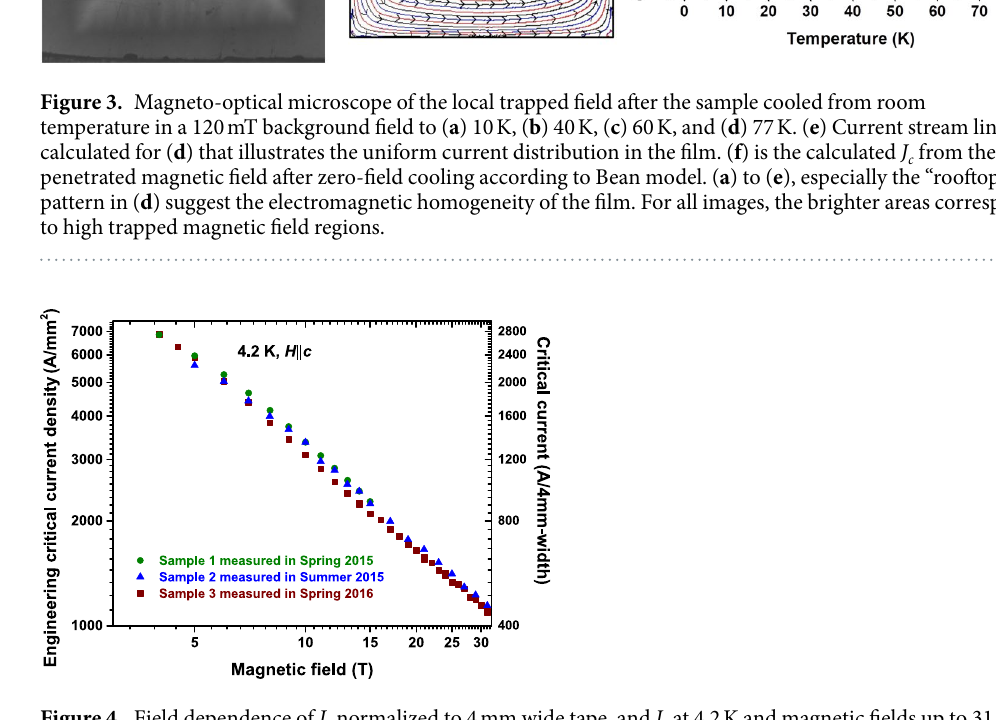
Figure 4. Field dependence of I c normalized to 4 mm wide tape, and J e at 4.2 K and magnetic fields up to 31.2 T. The ~3.2 μ m thick film exhibits remarkable J e > 1.0 kA/mm 2 at magnetic fields up to 31.2 T. J e was calculated based on the typical Hastelloy thickness of 50 μ m and copper stabilizer thickness of 40 μ